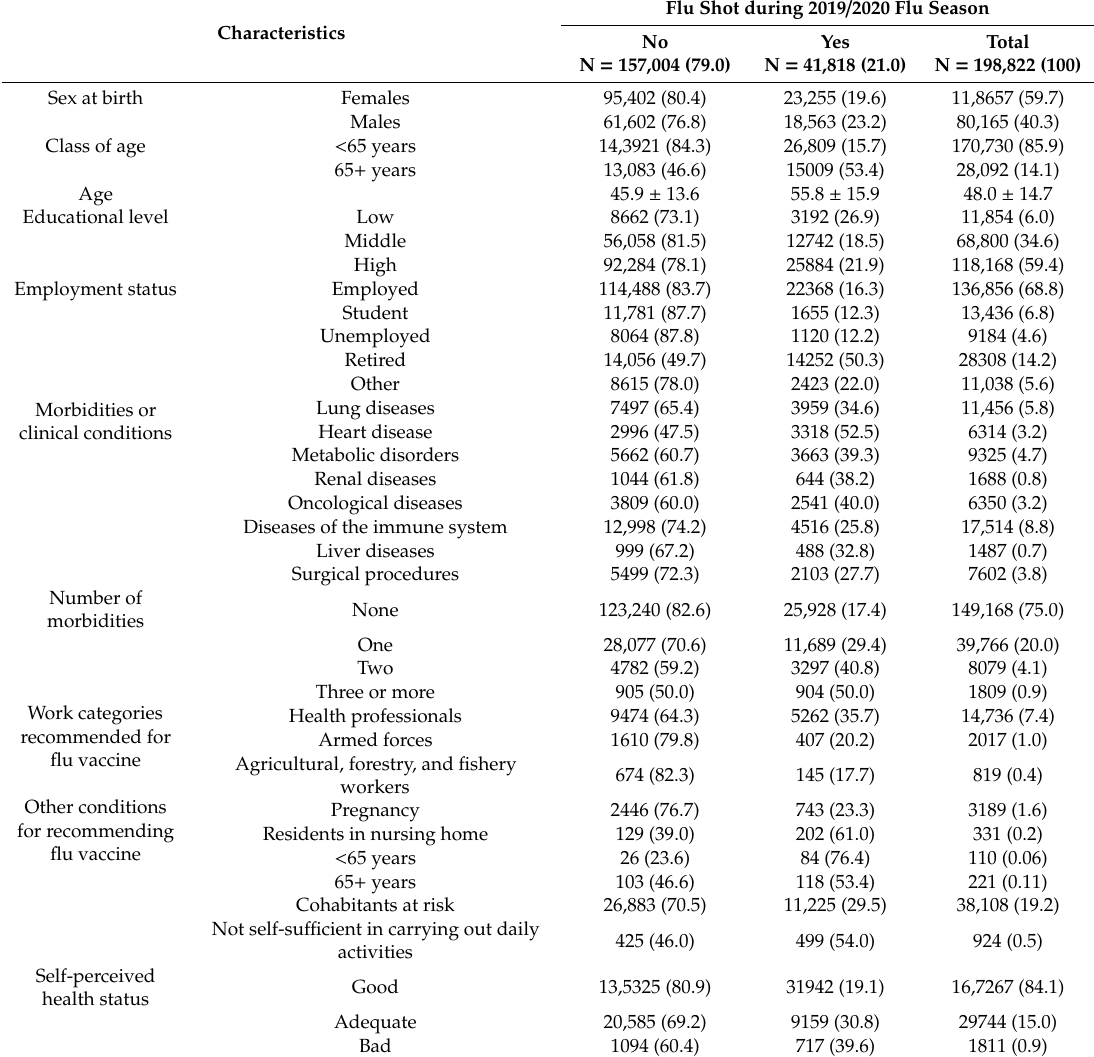
Table 1. Characteristics of study participants according to being vaccinated for influenza or not in the 2019 / 2020 flu